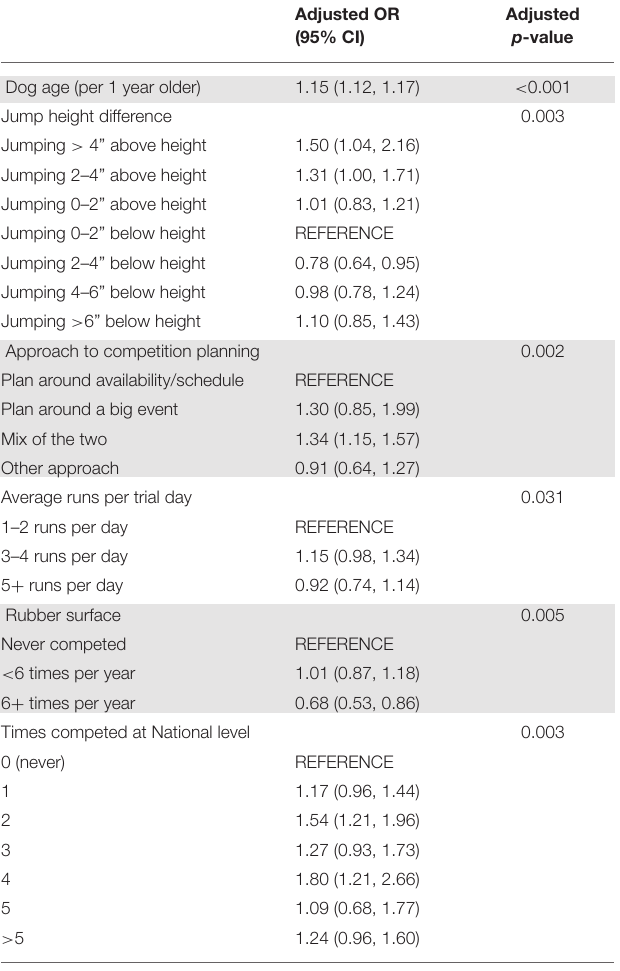
TABLE 2 | Coefficients from adjusted model with competition level factors only for any injury.